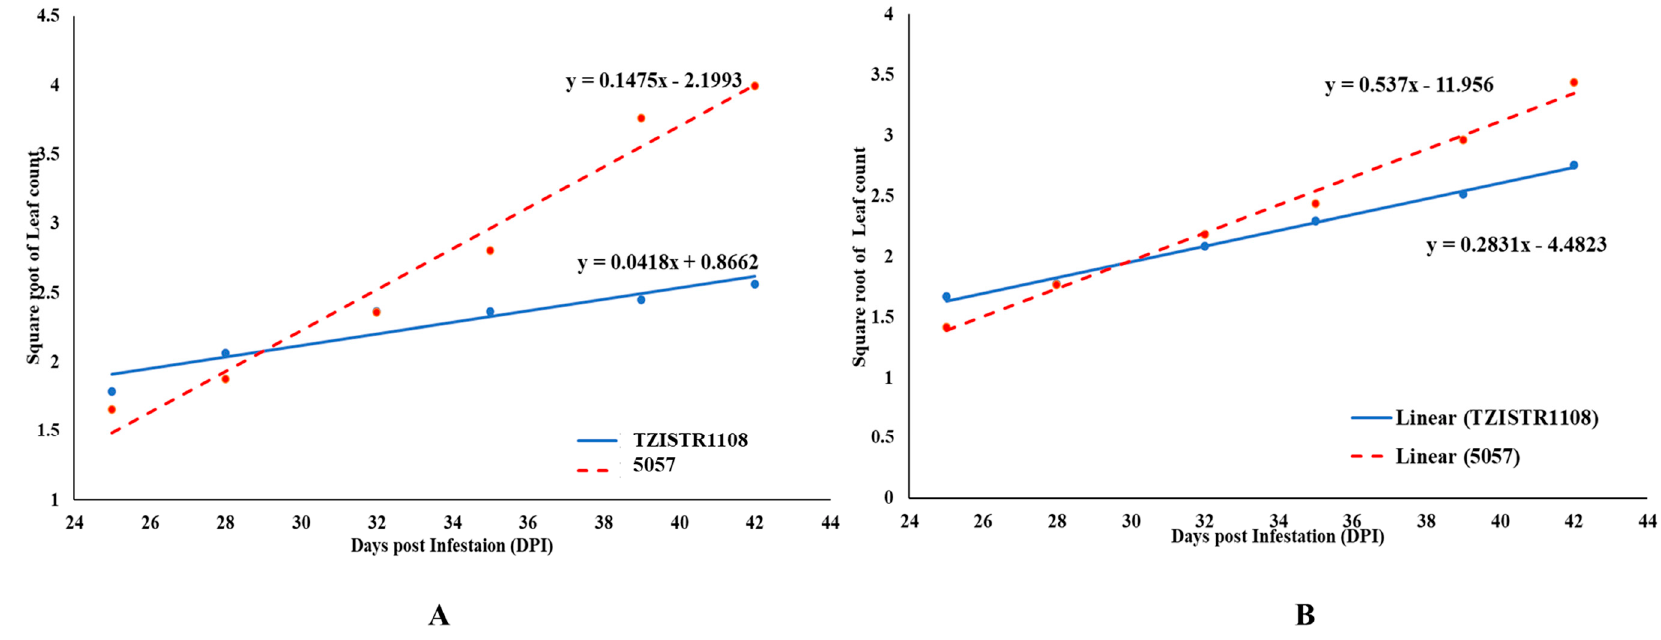
Figure 9. Regression lines of mean leaf count of Striga hermonthica plants on lateral roots ( A ) and major roots ( B ) of the two maize lines. The points represent the mean of the Square root of the number of leaves fully or partially opened leaves at days post infestation on selected S. hermonthica plants attached to a lateral root on 5057 and TZSTRI108 replicated 5 times.